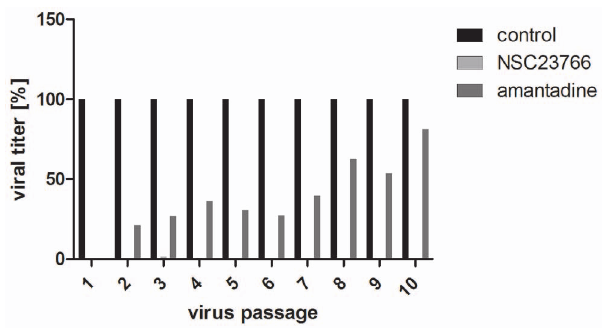
Figure 6. Inhibition of IV replication by NSC23766 exhibits a high barrier against the emergence of resistant virus variants. A549 cells were infected with A/FPV/Bratislava/79 (moi=0.001) in the presence of either NSC23766 (100 m M) or amantadine (5 m M) for 24 h. Two biological samples for each treatment group were titrated, combined, and used for the next round of infection with equal amounts of virus per well. Virus titers are shown as percentage of the untreated